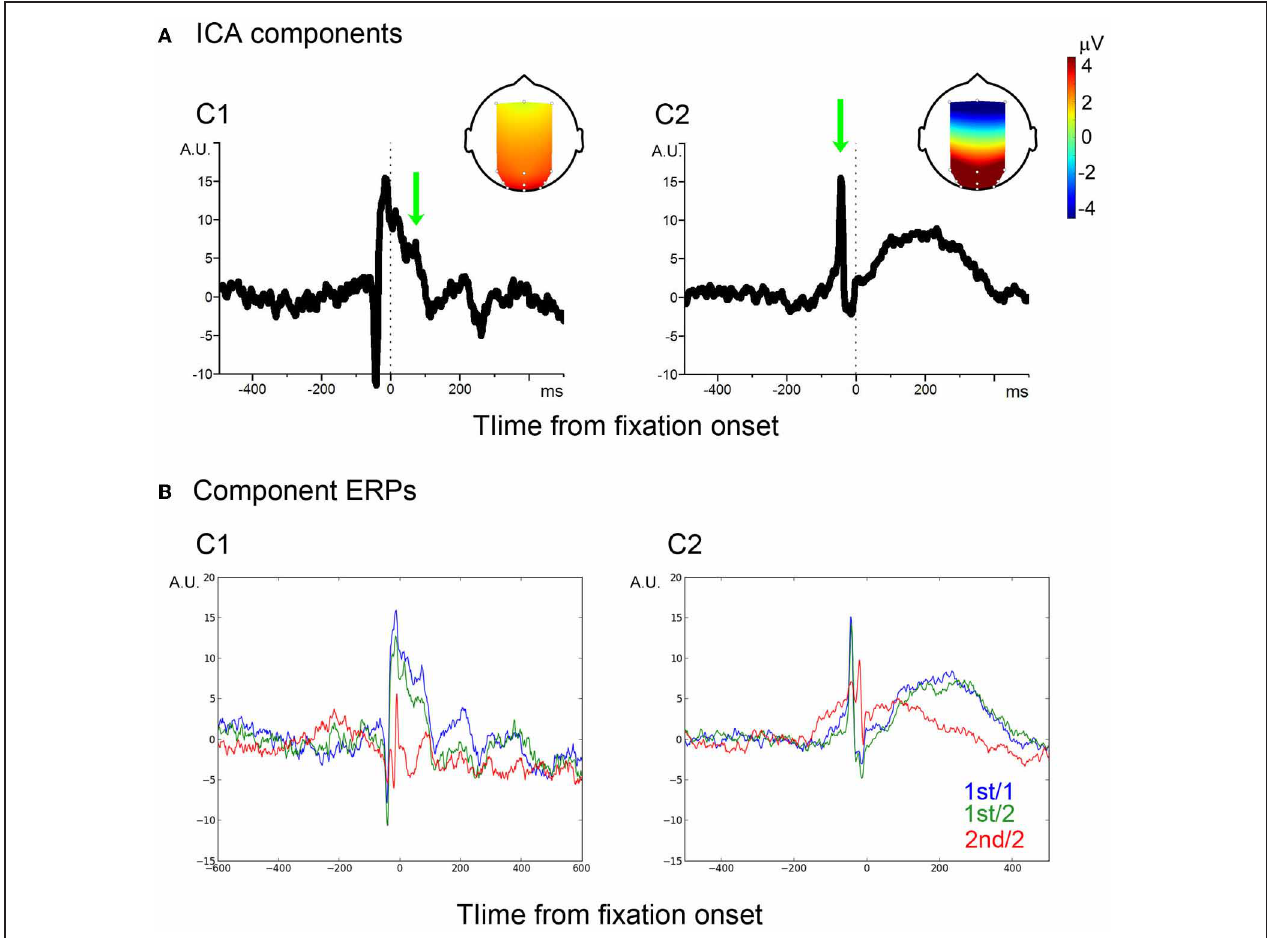
FIGURE 2 | ICA components. (A) Two ICA components, C1 and C2. Vertical dotted-lines indicate the fixation onset. Arrows indicate P1- and SP-equivalent activities, of which the scalp projections are shown in the head image. (B) Average of filtered signals.